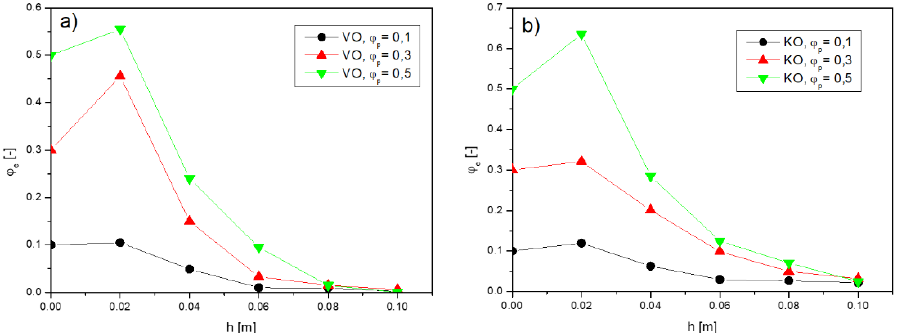
Figure 5. Changes in emulsion concentration with height of porous material for different emulsion concentrations: ( a ) vegetable oil emulsions, ( b ) kerosene emulsions. concentrations: ( a ) vegetable oil emulsions, ( b ) kerosene